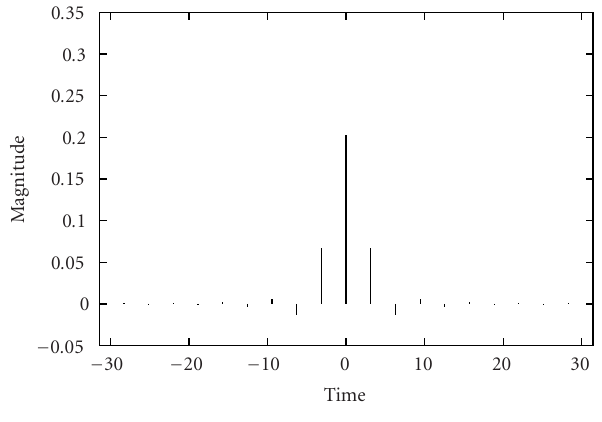
Figure 4.9. Halfcos discrete function. Table 5.1. Convergence of uncertainty product using cosine interpolation function with (cid:2) = 0 . 1 and W = π